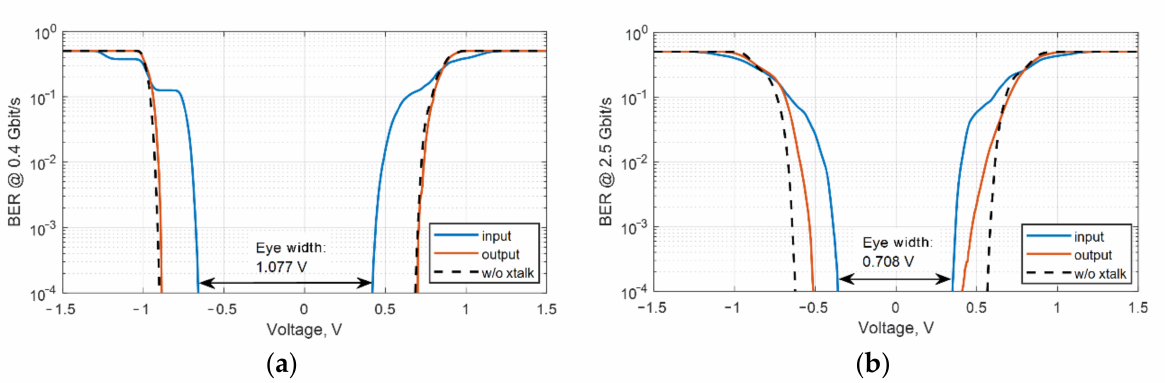
Figure 15. Bit error rate versus voltage for time 1.25 ns: ( a ) bit rate is 0.4 Gbit/s; ( b ) bit rate is 2.5 Gbit/s. The same statistical signal processing was performed for eight different bit rates from 0.4 Gbit/s to 2.5 Gbit/s: